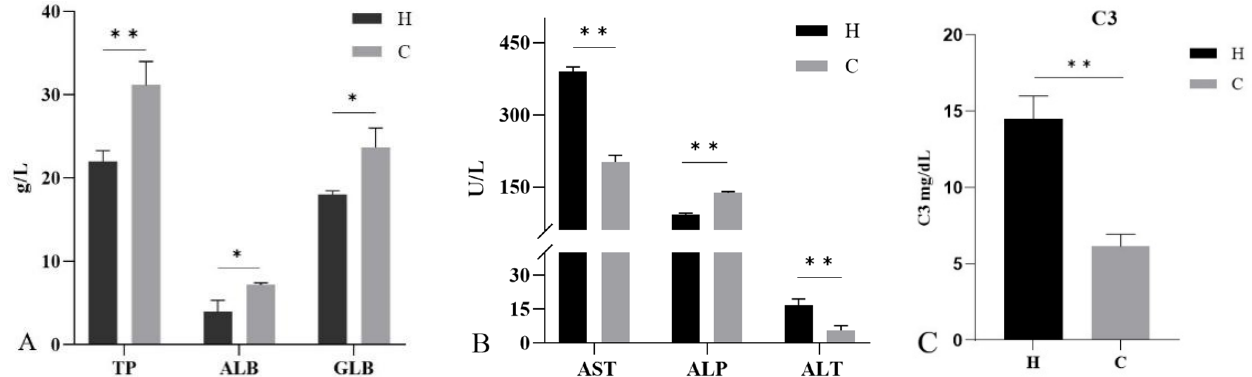
Figure 5. Serum biochemical indices of hybrid sturgeon: ( A ) Total protein (TP), albumin (ALB), and globulin (GLB); ( B ) Aspartate aminotransferase (AST), alkaline phosphatase (ALP), and alanine aminotransferase (ALT); ( C ) Complement C3 (C3). H, diseased hybrid sturgeon (H-701); C, healthy hybrid sturgeon (Control); * p < 0.05; ** p < 0.01.